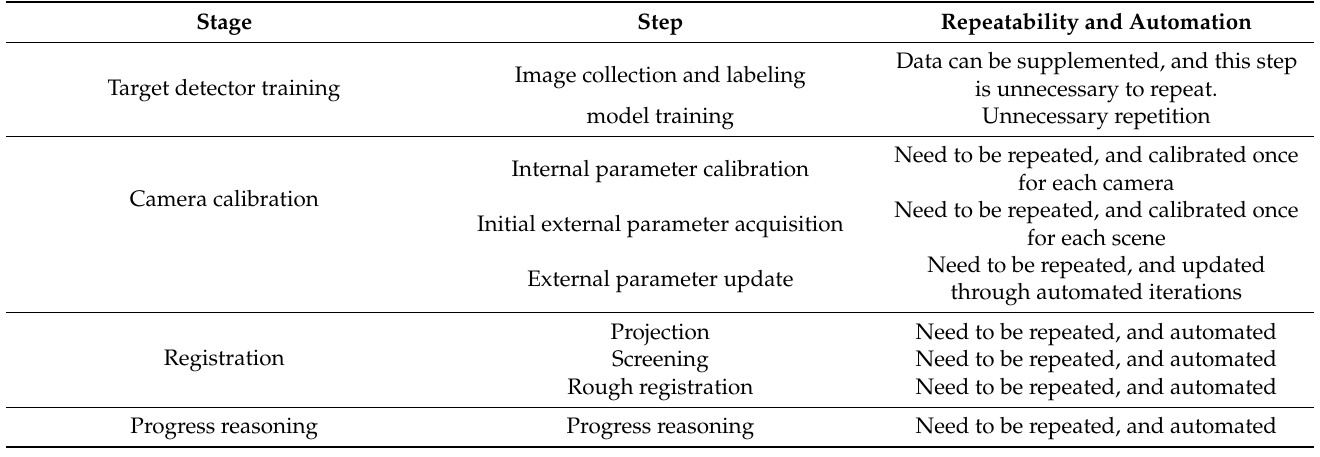
Table 5. Repeatability and automation of steps in future